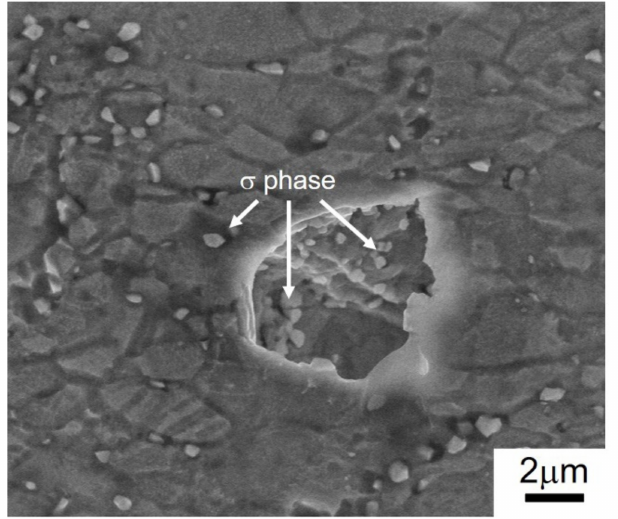
Figure 10. Crack nucleation in UFG 316LN stainless steels annealed at 800 ◦